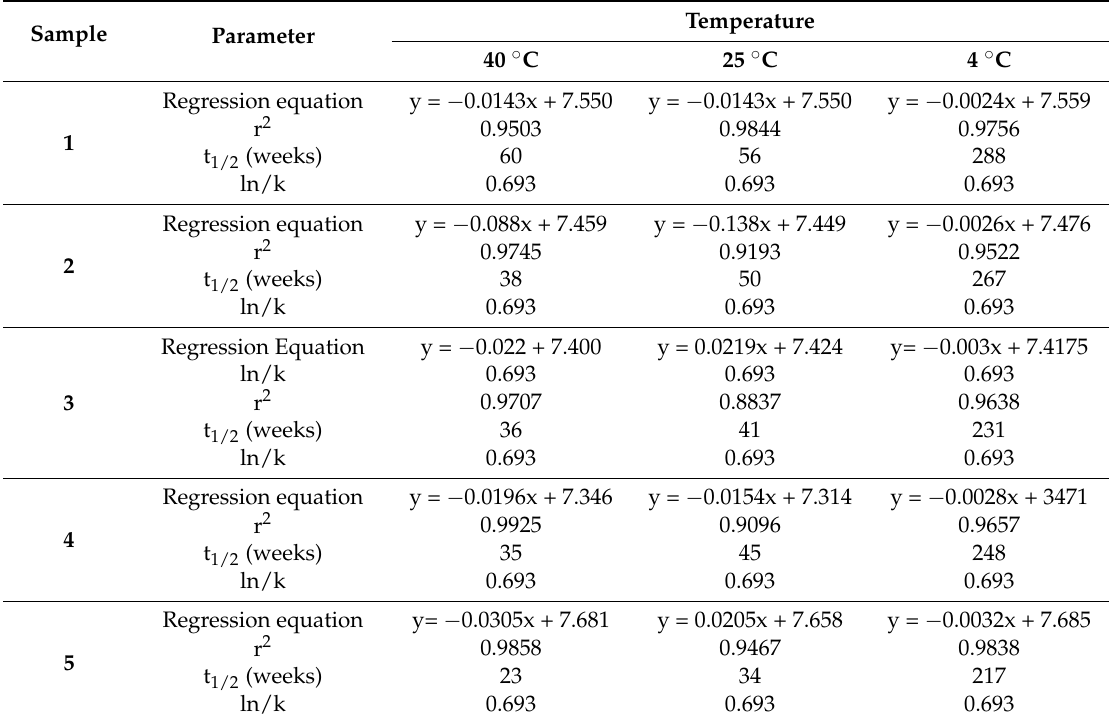
Table 2. Regression analysis of degradation reaction rate of green tea catechin in the